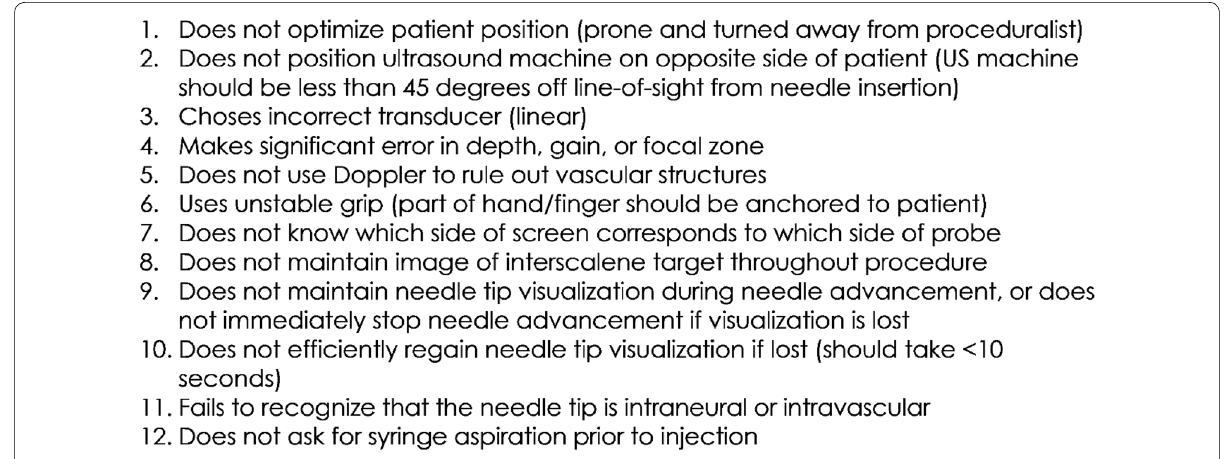
Fig. 3 Needle placement scoring metric. Passage of this assessment required identification of the needle tip in the interscalene groove along with the presence of 4 or fewer of the following behaviors (adapted from Wong et al.